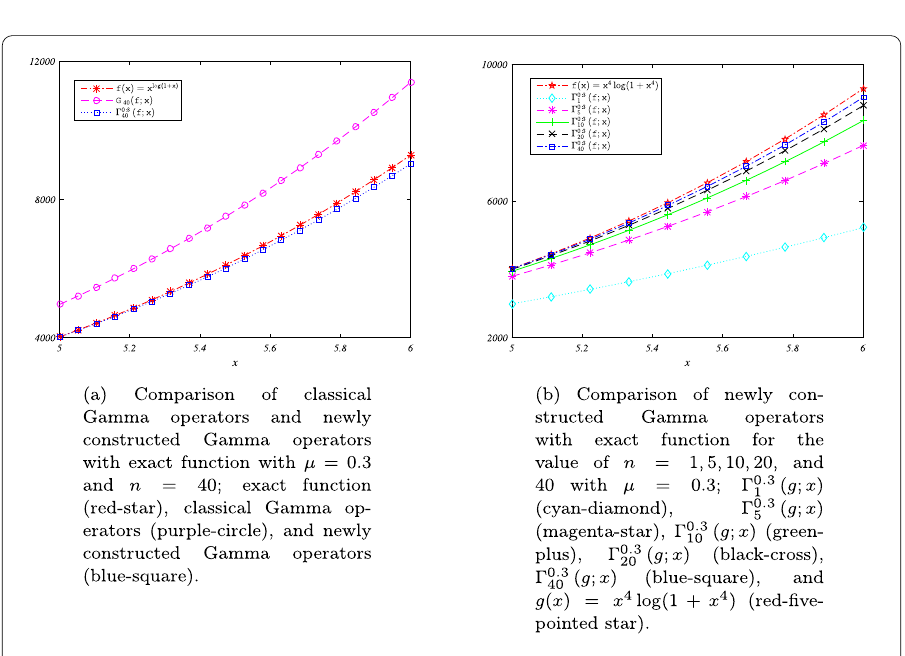
Figure 2 Approximation of target function g ( x ) on an equally spaced evaluation grid of [5,6]